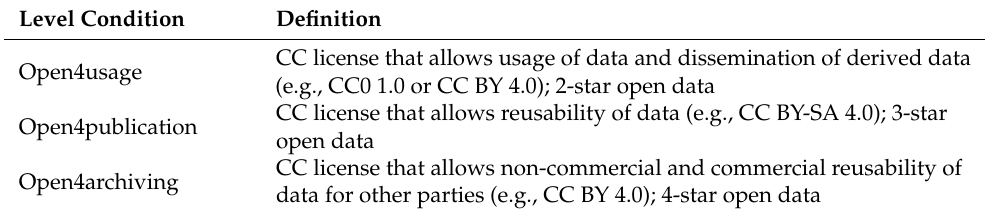
Table 3. Proposed level condition definitions for openness of